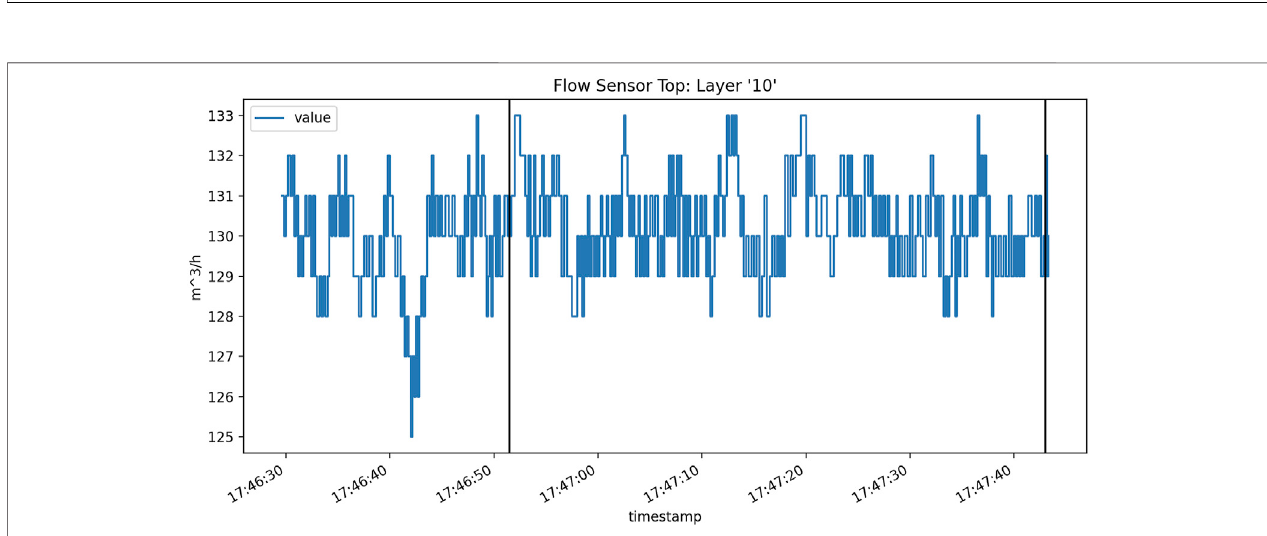
FIGURE 2 | A plot of a single layer of log fi le data for “ FlowSensorTop ” from build 1. The black vertical lines indicate where the melt phase begins and ends for this layer.